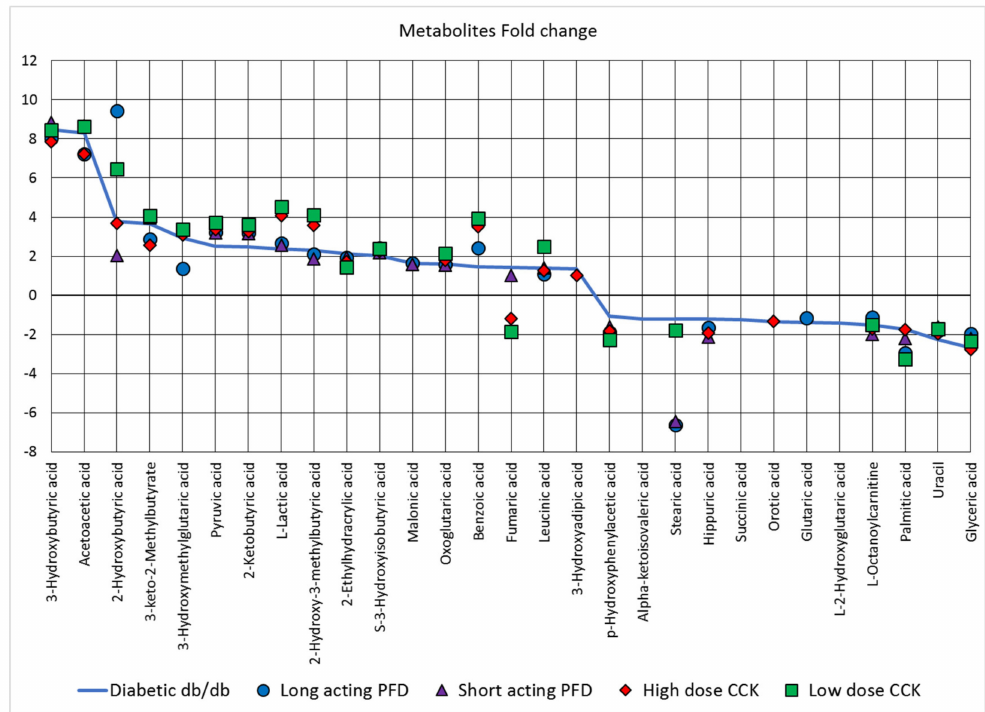
Figure 7. The log fold change of 29 metabolites di ff erentially abundant in diabetic db / db mice (shown as a solid blue line) as compared to the control db / m mice (baseline at zero on the y-axis). The metabolites above the baseline at zero are more abundant, whereas metabolites below the baseline at zero are less abundant in db / db mice as compared to control db / m mice. The symbols represent the log fold change of the respected four treated mice groups in comparison with the control db / m